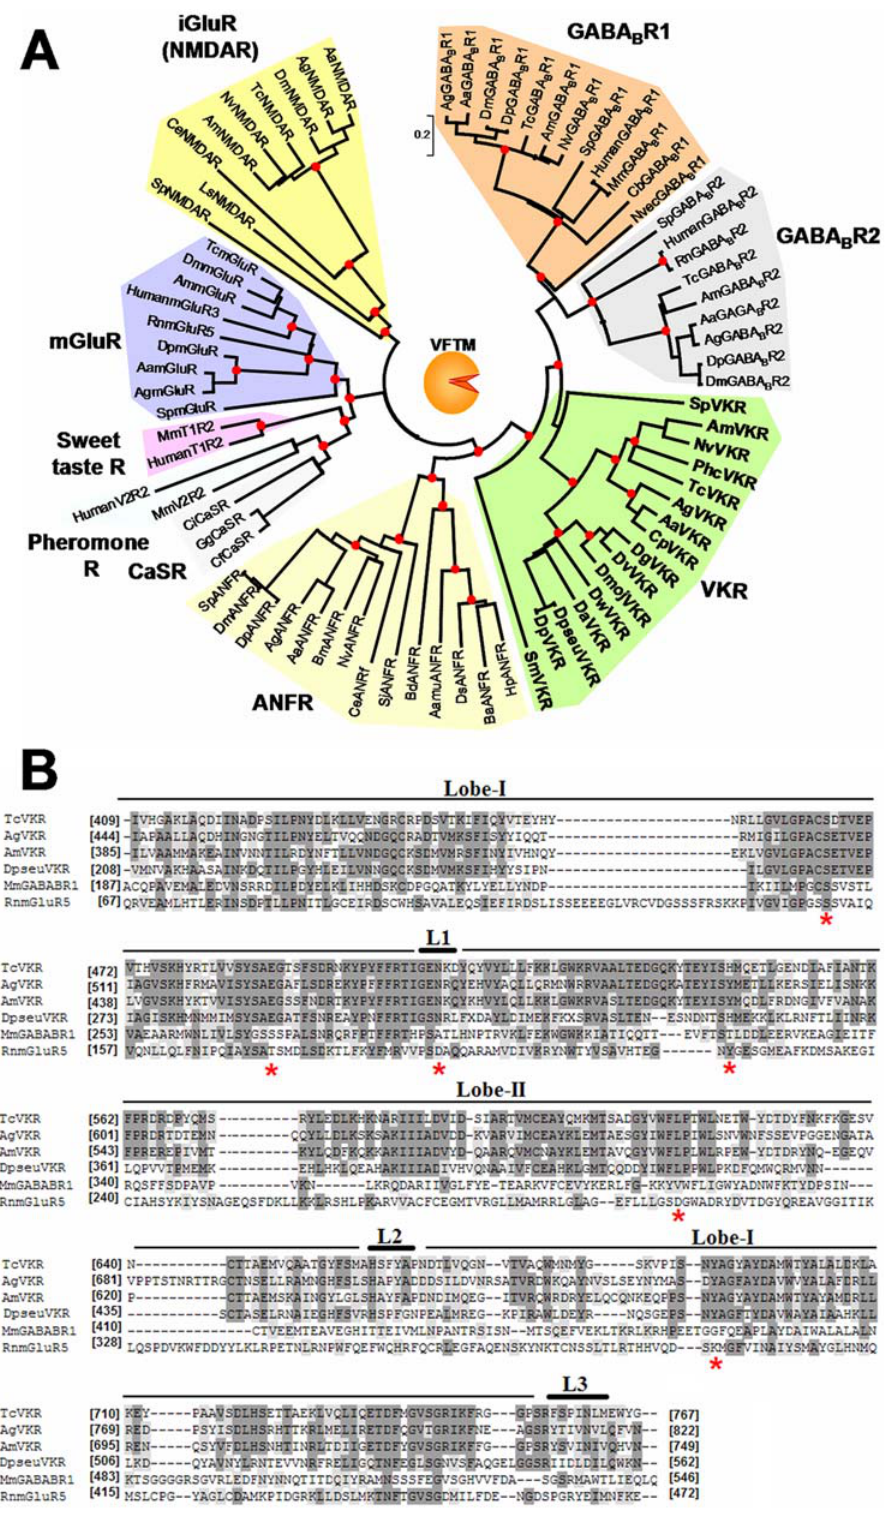
Figure 4. Phylogenetic analyses and sequence alignment of VFTM from VKR. A-Phylogenetic relationship of VFT protein domains from VKR and VFT-containing receptors, GABA B receptor (GABA B R1 and GABA B R2 subunits), the natriuretic peptide receptor (ANFR), the metabotropic glutamate-like receptors (mGluR, sweet taste, pheromone and CaSR calcium receptors) and the iGluR N-methyl-D-aspartate (NMDA) receptor mostly from insects and invertebrates. Bootstrap values (10 000 replicates) higher than 80% were shown by a red point on the major internal node only. Genbank accession numbers of receptors used are in table S1. B- Sequence alignment of VFT protein domains from different insect VKRs (AmVKR, TcVKR, AgVKR and DpseuVKR for which cDNA was cloned and sequenced) with the extracellular domain of the human GABABR1 (Q9UBS5) and of the